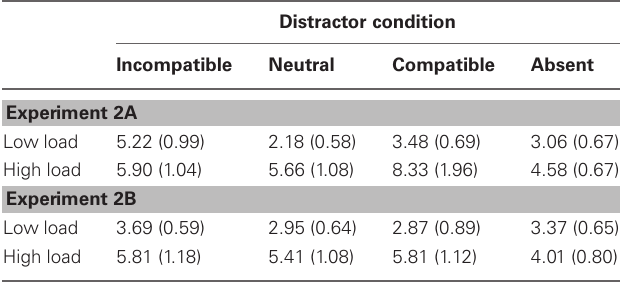
Table 2 | Percent error rates listed as a function of perceptual load and distractor condition in Experiments 2A and